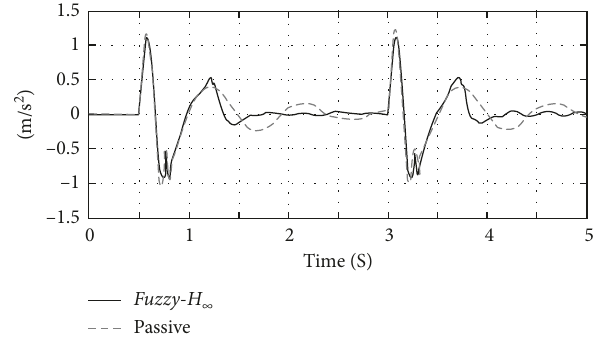
Figure 15: COG chassis acceleration.